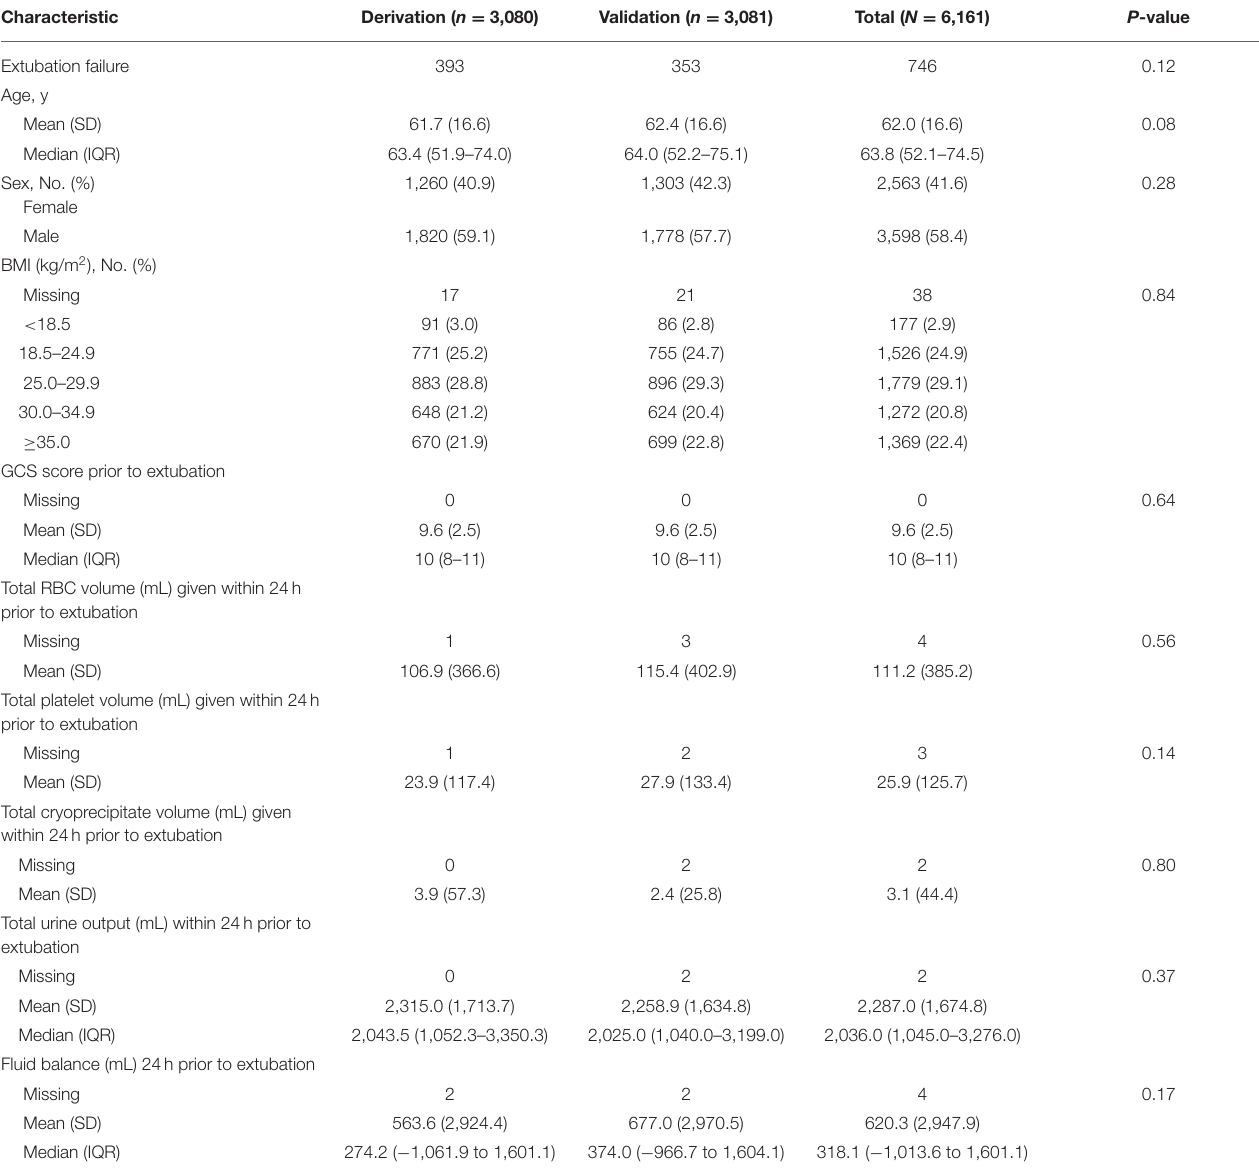
TABLE 1 | Baseline demographic and hemodynamic instability and fluid